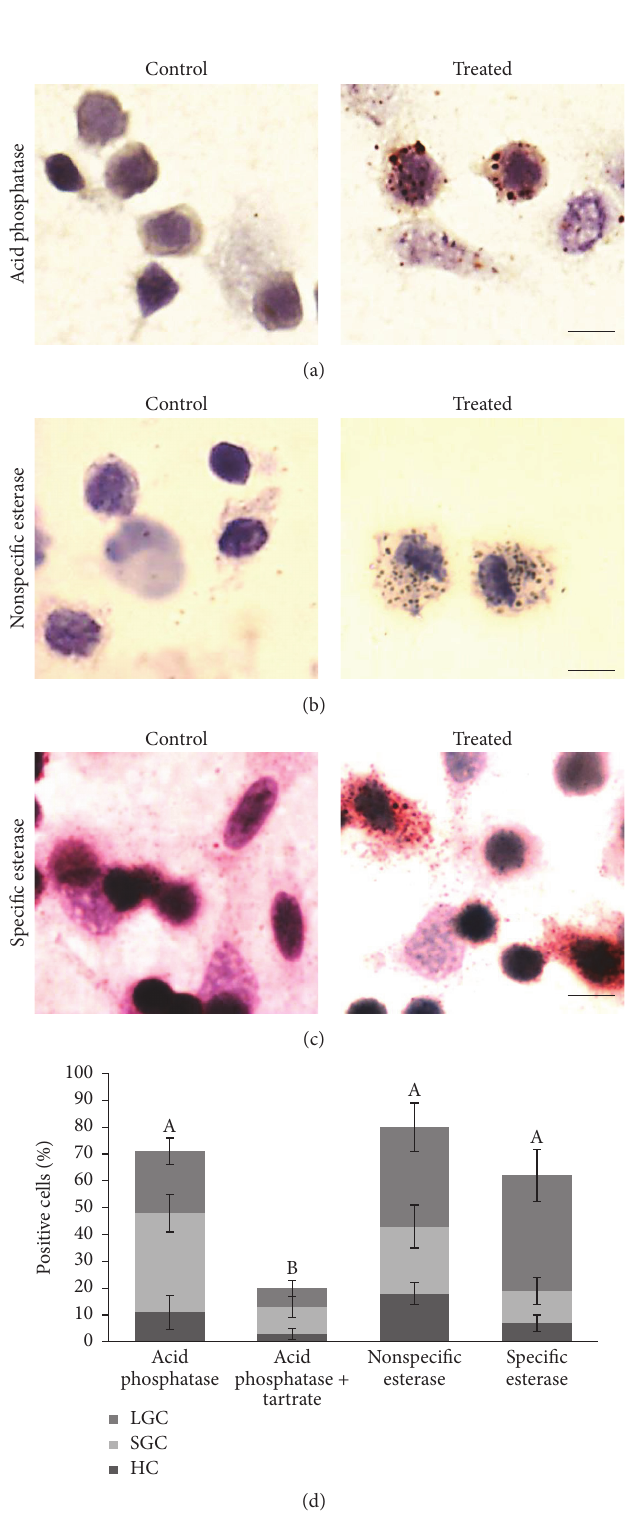
Figure 3: Enzyme cytochemistry of adhered hemocytes isolated from Litopenaeus vannamei . The first column of micrographs corresponds to the control cells incubated without the enzyme substrate and the second column shows enzymatic activities. (a) Acid phosphatase, (b) nonspecific esterase (alpha-naphthyl esterase), and (c) specific esterase (AS-D chloroacetate esterase). Scale bar = 5 𝜇 m. (d) Percentage of adhered hemocytes of L. vannamei , which react with the substrates for different enzymes, along with cell types of positive cells. Data represent mean ± SD. Letters indicate significant differences ( 𝑃 < 0.05 ) in percentage of positive